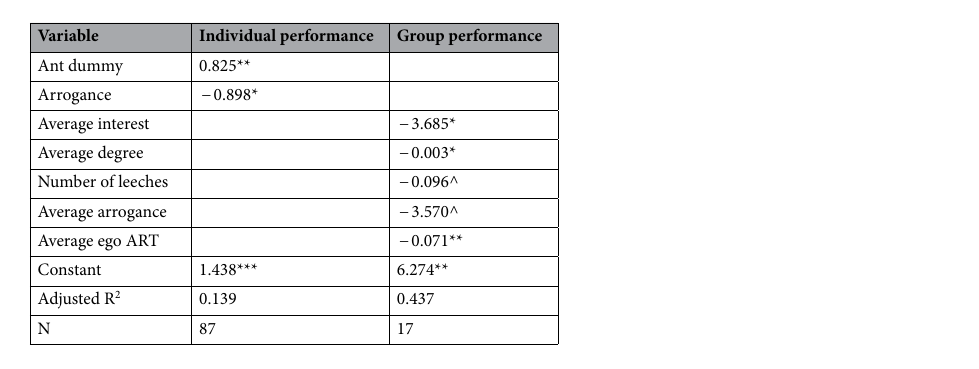
Table 5. Regression analysis—Service Company dataset. ^p < 0.1; *p < 0.05; **p < 0.01; ***p <